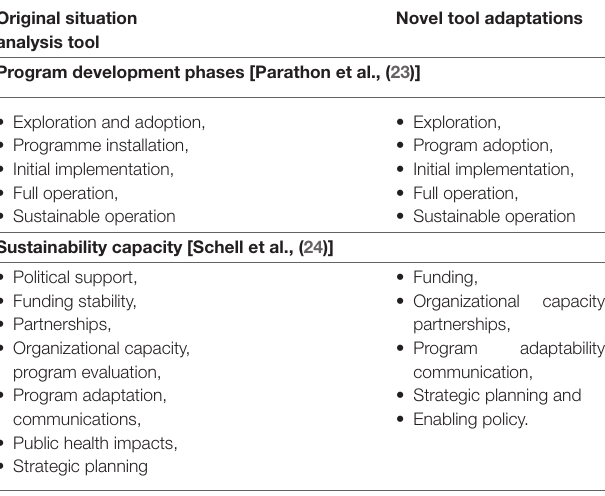
TABLE 2 | Comparison of our One Health Evaluation of Antimicrobial Resistance Surveillance (OHE-AMRU) tool to existing methods that were adapted to fit our